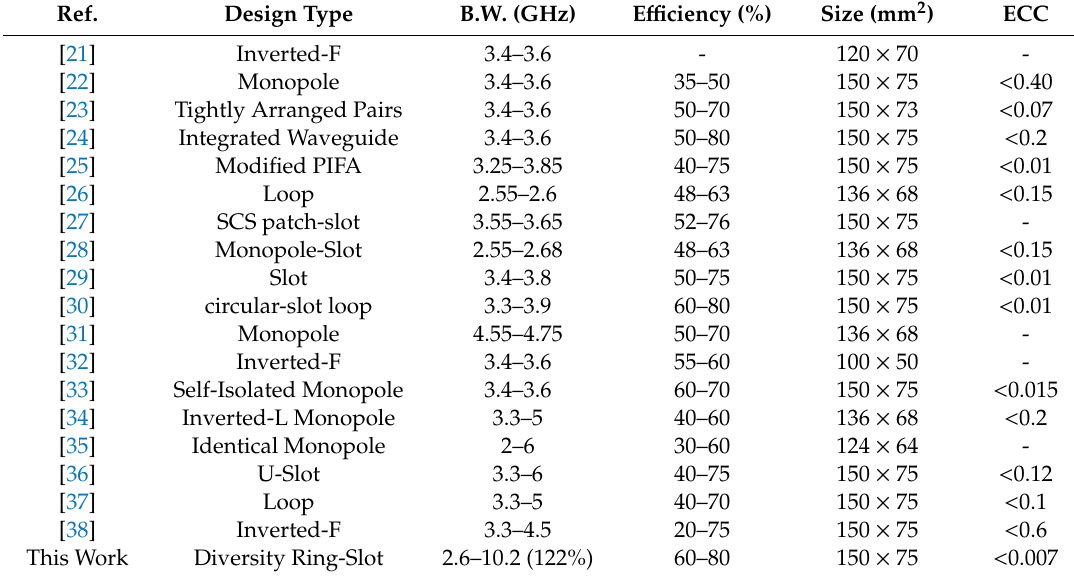
Figure 23. Calculated ( a ) ECC and ( b ) TARC results of the UWB smartphone antenna from measured/simulated results. Table 3. Comparison between the Proposed Smartphone Antenna and the Reported MIMO Antennas.